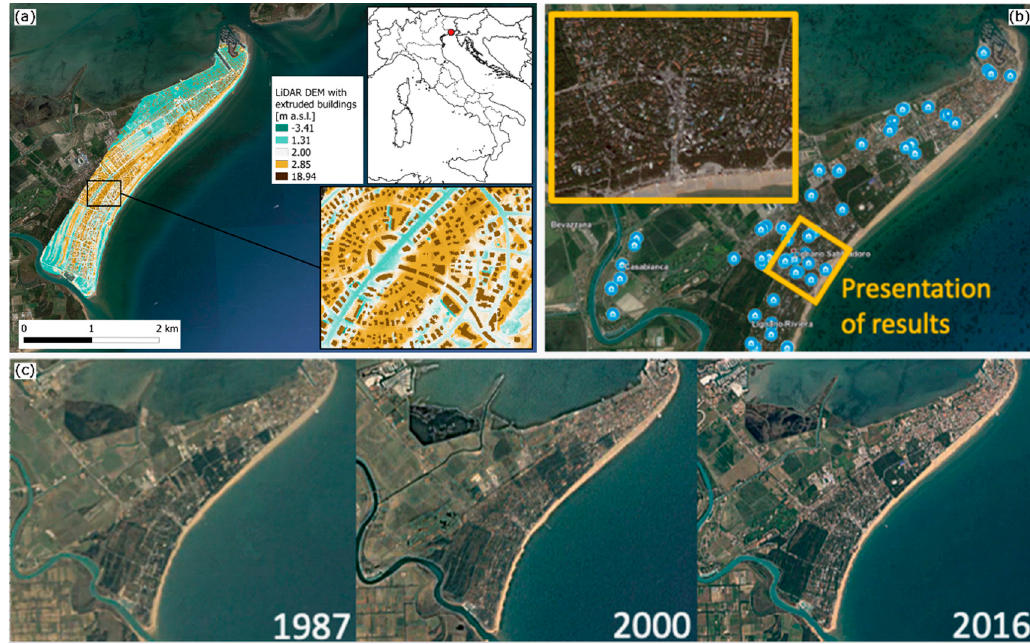
Figure 5. Geographic and topographic setting of Lignano Sabbiadoro (Northern Italy). ( a ) 2 m LiDAR Digital Elevation Model (DEM) with extruded buildings; ( b ) reported requests for emergency services as a consequence of the 10–12 September, 2017 event, and selected area for the presentation of results. Panel ( c ) reports recent land-use dynamics for the years 1987, 2000 and 2016 (source: Google Earth).